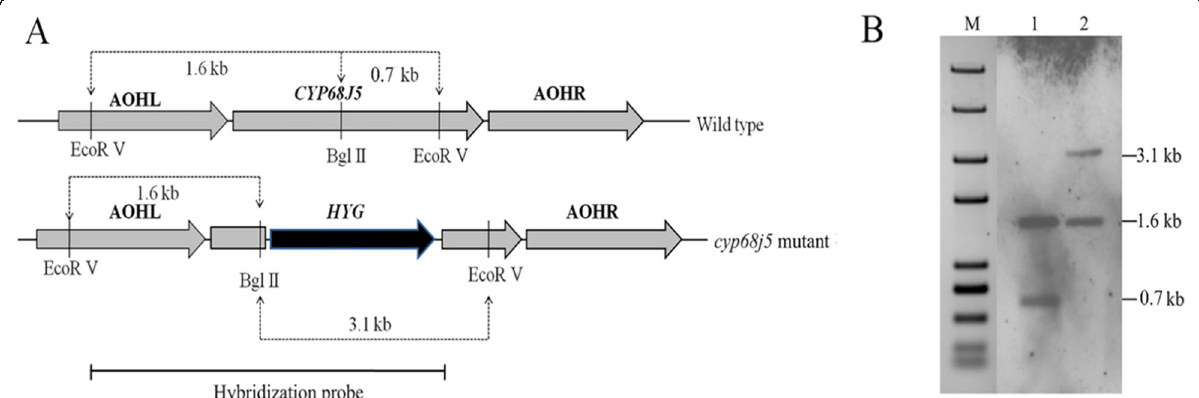
Fig. 4 Confirmation of the disruption of CYP68J5 by southern blot. a The strategy for southern blot, total DNA from each strain was digested with EcoRV/BglII and probed with a hybridization probe. b Detection of the disruption of CYP68J5 in the cyp68j5 mutant by southern blot analysis: lane